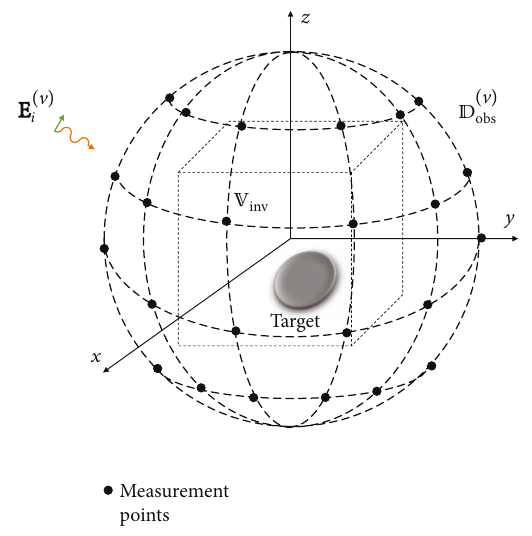
Figure 1: Schematic representation of the considered imaging con fi